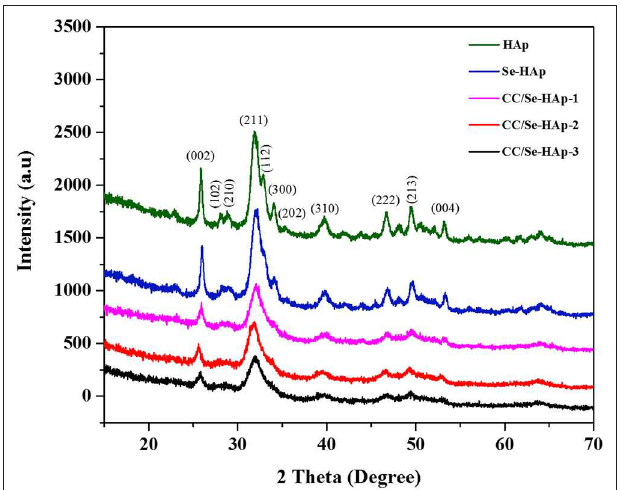
FIGURE 2 | Fourier transform infrared spectra of pristine HAp, Se-HAp, and its modification with different concentrations of catechins, i.e., 5% (CC/Se-HAp1), 7% (CC/Se-HAp2), and 10% (CC/Se-HAp3). The peaks show that both HAp and Se-HAp presented the typical HAp functional groups, with a decrease in intensity (1,000 cm − 1 ) upon catechins